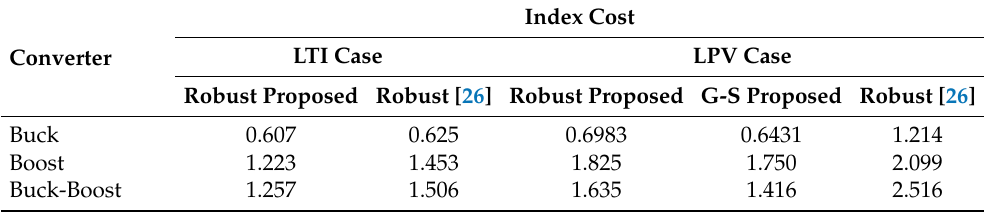
Table 3. Results of simulation in the PV